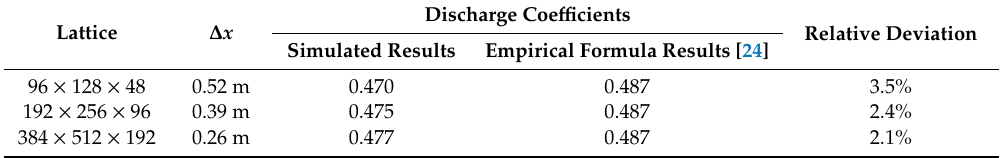
Table2. Relativeerrorbetweenthesimulatedresultsandempiricalformularesultswithdi ff